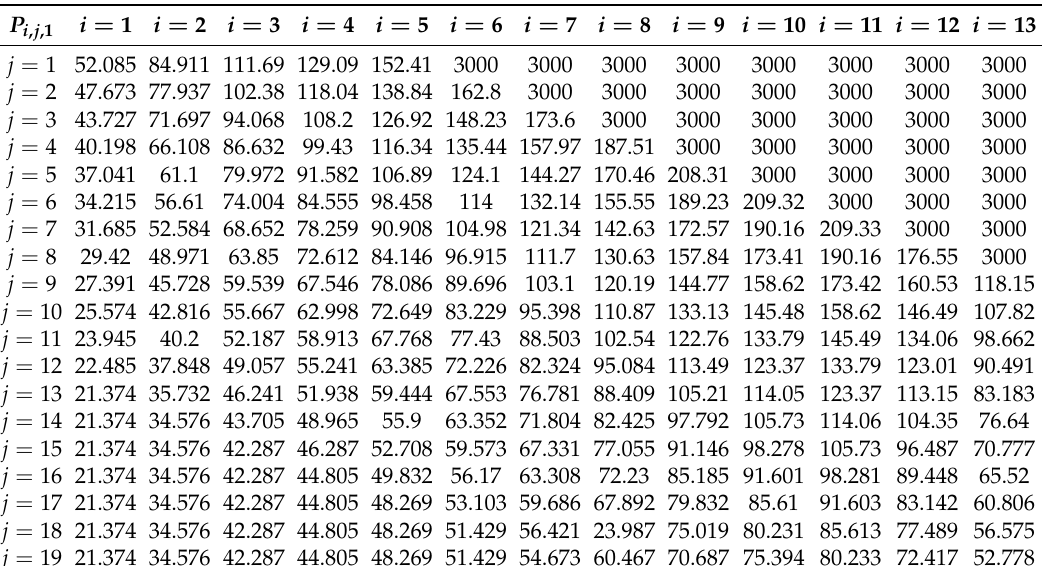
Table A5. Decay heat power of an assembly of OL1-2 belonging to the removal i ∈ I in the period j ∈ J P i , j ,1